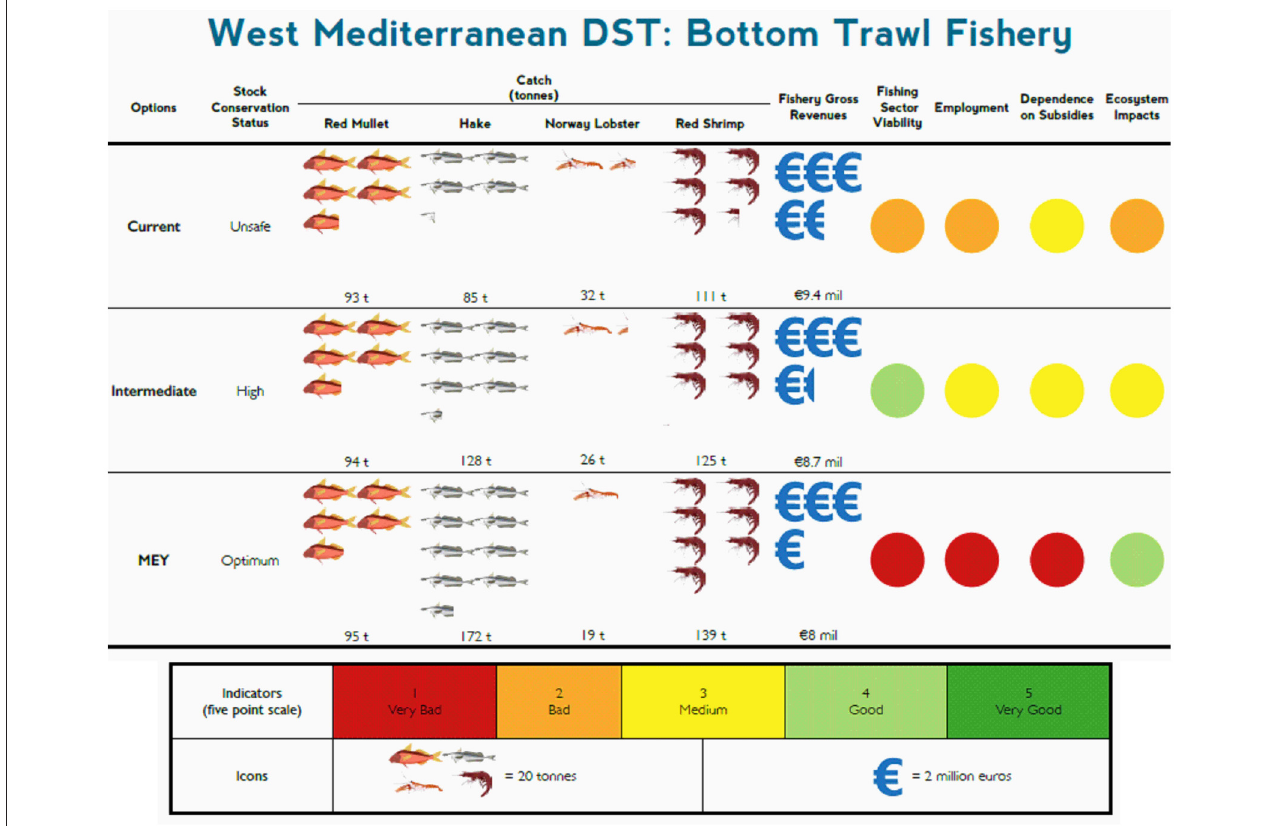
FIGURE 3 | Visualized form of the Decision Support Table from the bottom trawl